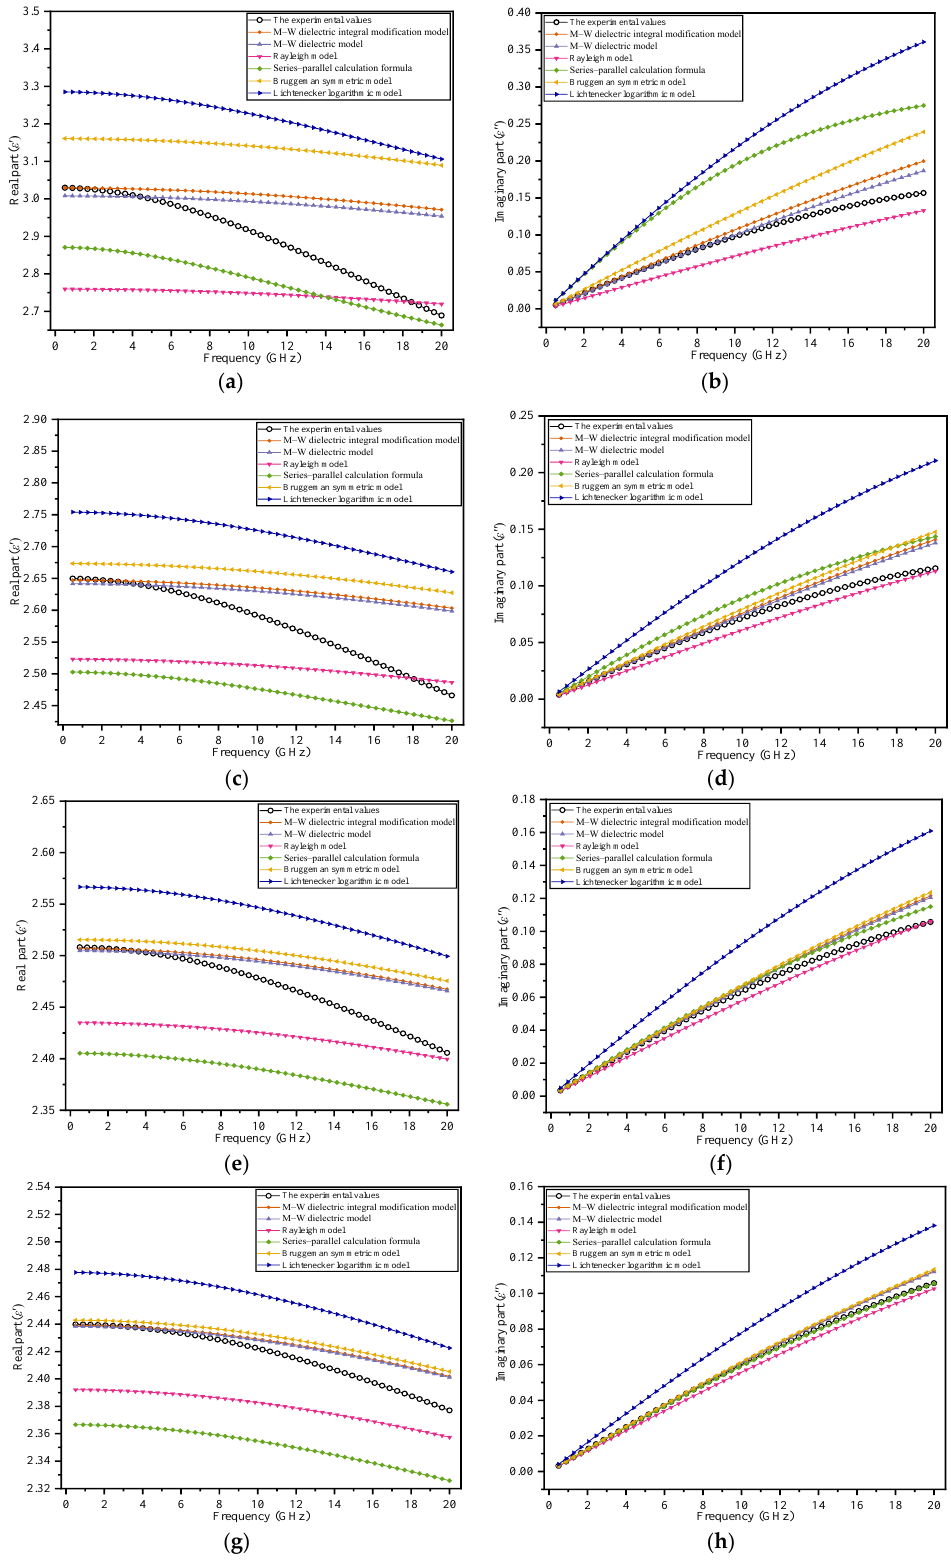
Figure 5. Comparison between theoretical models and experimental values under multiple moisture contents: ( a , b ) φ = 10%; ( c , d ) φ = 5%; ( e , f ) φ = 3%; ( g , h ) φ = 2%.